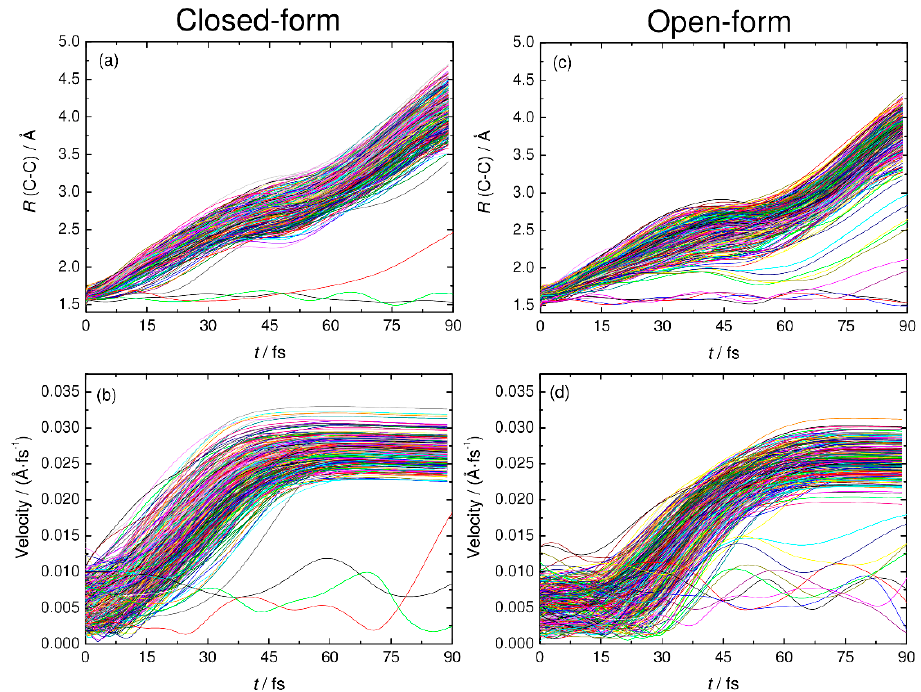
Figure 5. The C-C distance and relative velocity between CO 2 and HOCO plotted as function time for all the RPMD trajectories examined in this work. Panels ( a ) and ( c ) show the results of the C-C distance for closed-form and open-form, respectively. Panels ( b ) and ( d ) show the results of relative velocity for closed-form and open-form, respectively.